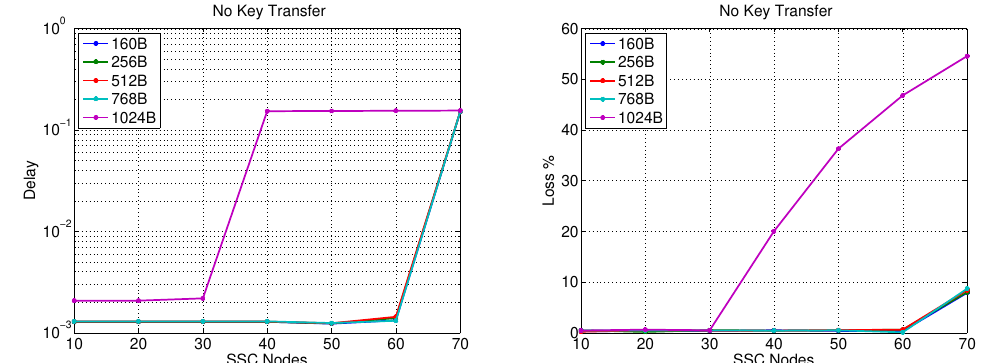
Figure 9. Gateway-PS communication performance for one SSC with different number of SSs (no key transfer).